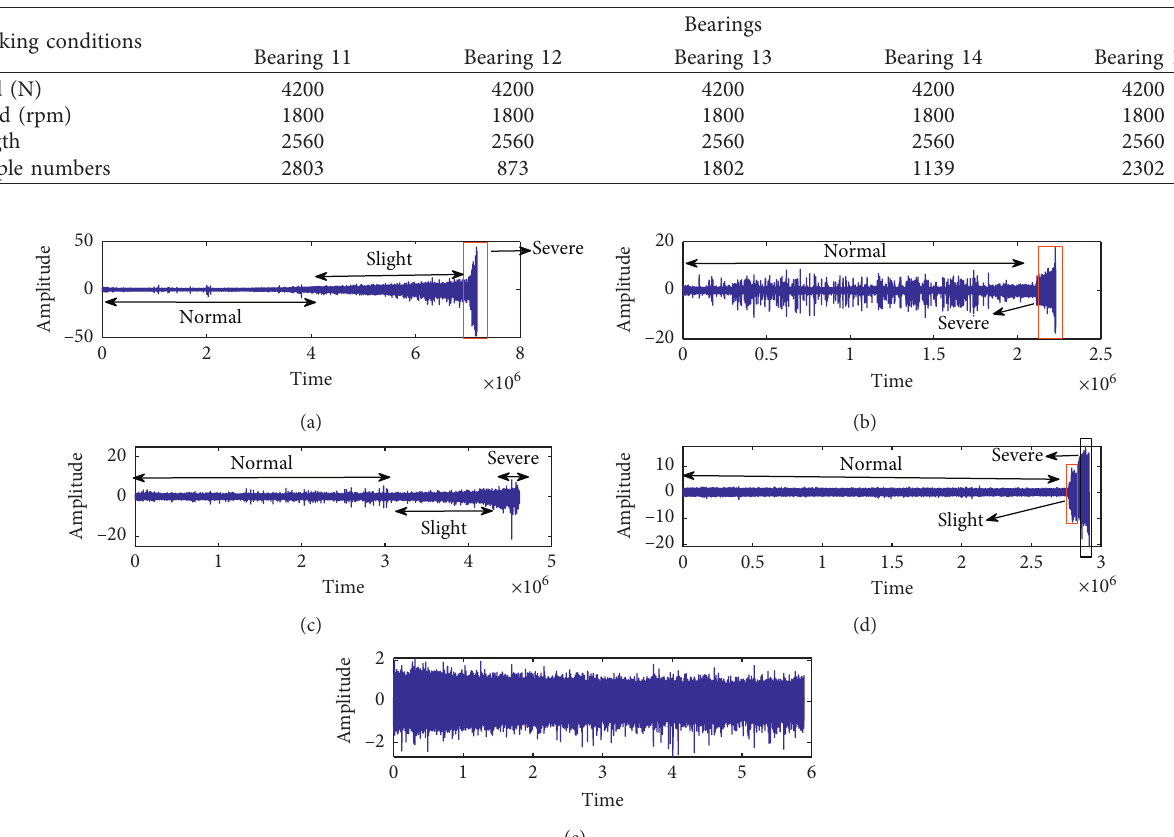
Table 1: Detailed information on the experimental data.